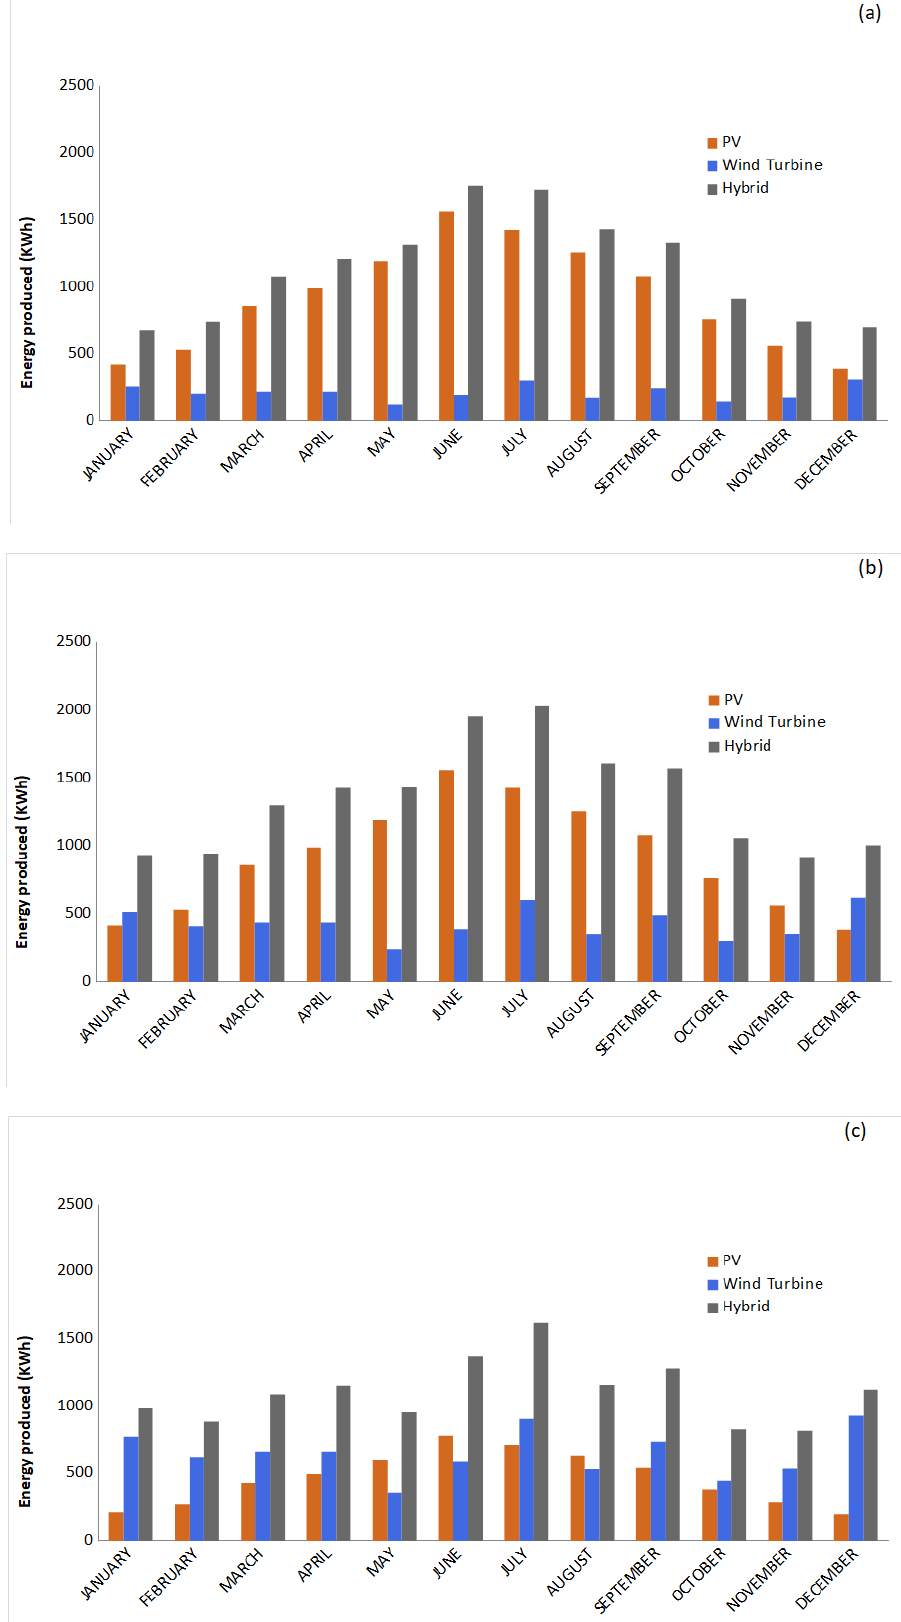
Figure 4. Monthly energy production of the photovoltaics, wind, and hybrid systems for scenarios